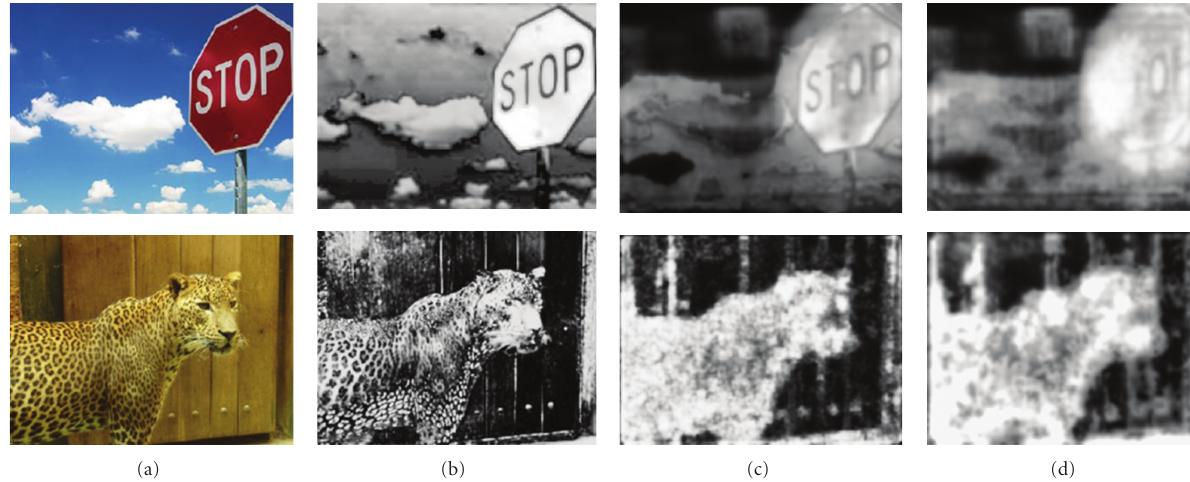
Figure 5: Examples of global and local saliency features: original image (a), global saliency map (b), local saliency map (c), and final saliency